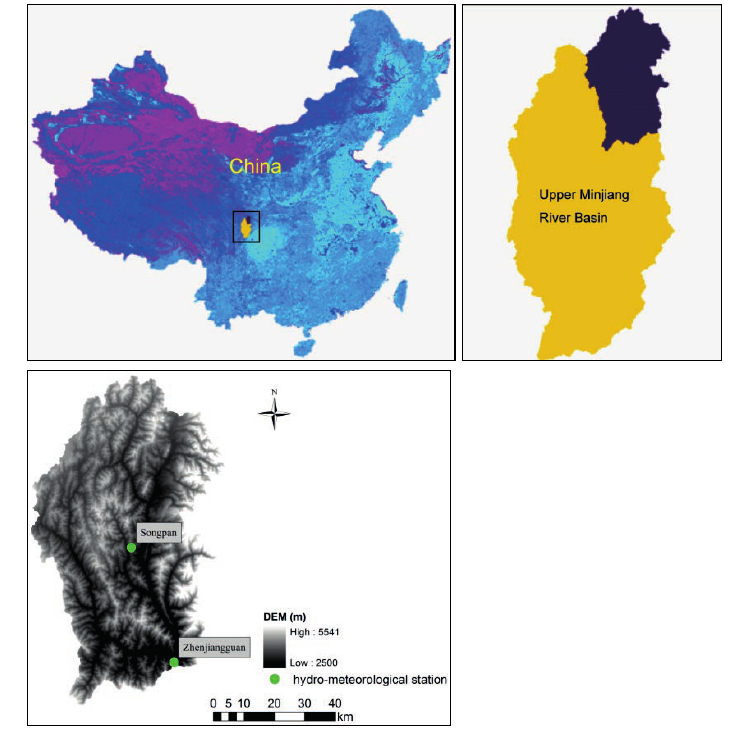
Fig. 1 Location of Zhenjiangguan watershed.